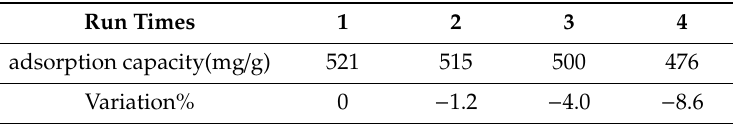
Table 5. Variations of the adsorption capacity with